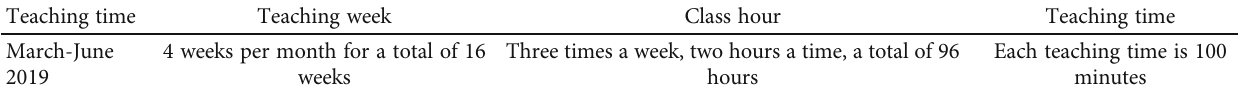
Table 2: Experiment time and teaching arrangement.